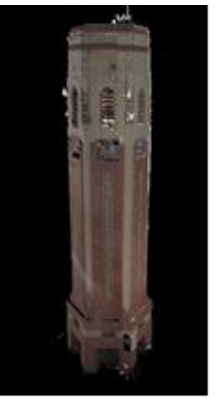
Figure 2. Coloured Point cloud